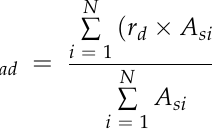
also in inundation duration.